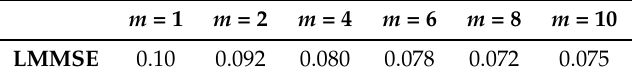
Table 3. Predictor errors in lmmse.